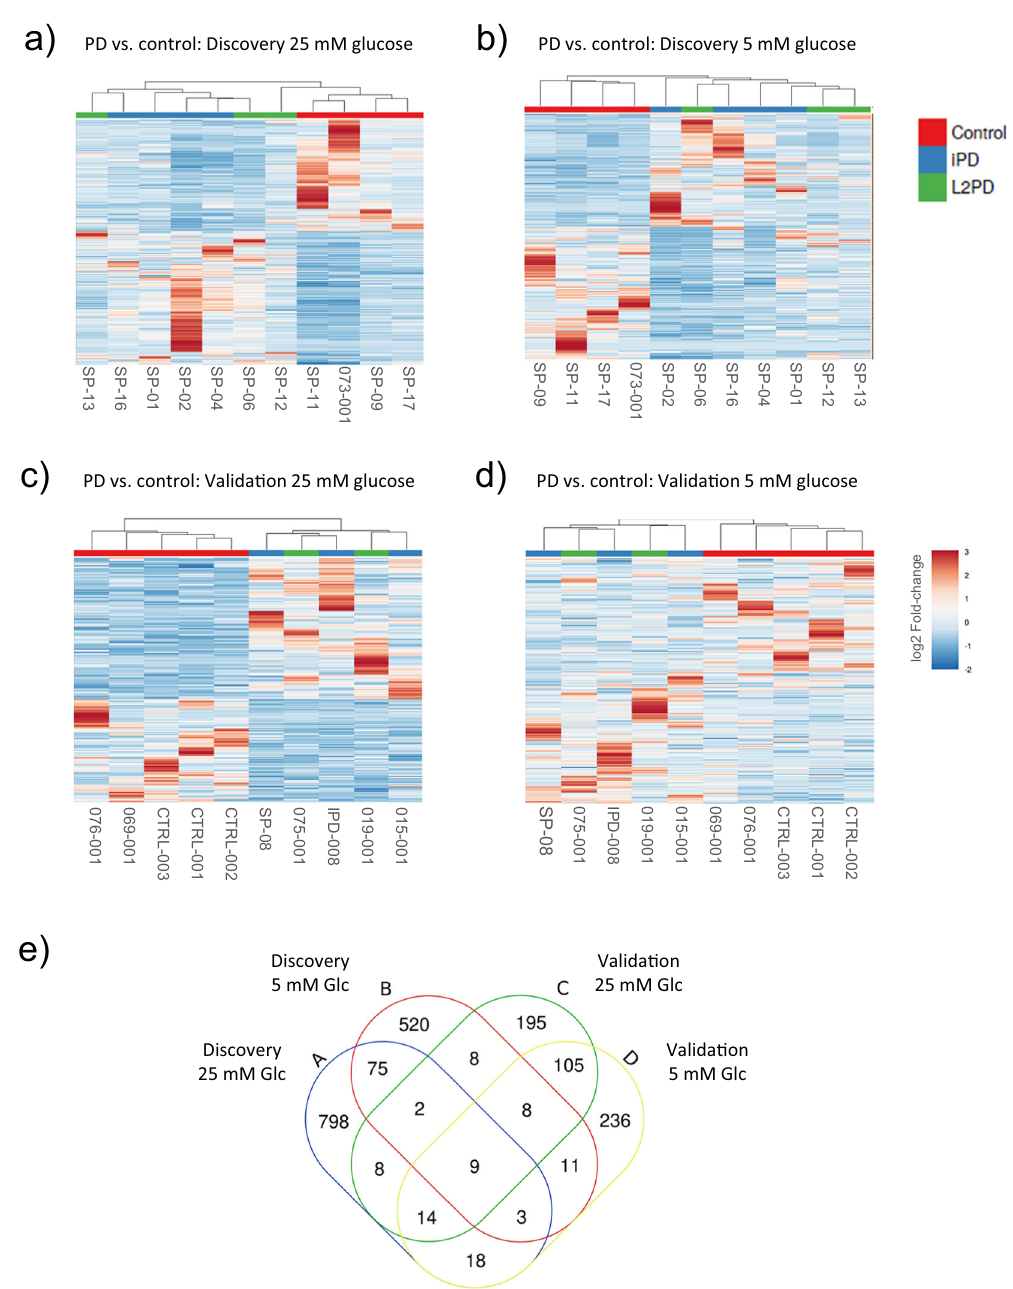
Fig. 2 Hierarchical clustering analysis of L2PD patients, iPD patients, and controls with heatmap density color representation of differentially expressed genes (DEGs) across different comparisons. a Discovery cohort at 25 mM glucose. b Discovery cohort at 5 mM glucose. c Validation cohort at 25 mM glucose. d Validation cohort at 5 mM glucose. Heatmaps of DEGs ( P -value<0.05 and fold change FC ≥ |2|) were performed using default settings at the Clustvis software. e Venn diagram representation showing DEG overlap between PD vs. controls in the four different comparisons, where “ A ” corresponds to discovery 25 mM glucose, “ B ” discovery 5 mM glucose, “ C ” Validation 25 mM glucose, and “ D ” validation 5 mM glucose. Clustvis: fi ndings that the main expression changes detected in iPD and neuron or synapsis in iPD and L2PD. These results can be L2PD fi broblasts are related to cytoskeleton rather than interpreted given that neurons and non-neuronal peripheral cells mitochondria, additional functional studies investigating the such as fi broblasts share common molecular mechanisms invol- interplay between gene expression deregulation and ving cell adhesion and extracellular matrix leading to fi lopodia and cytoskeleton-related processes are warranted in PD fi broblasts, most especially given the easy availability and robustness of this cell model. In addition, some of the top hits across all comparisons (Fig. 1) have been previously linked to PD. For example, the APOC4-APOC2 protein was signi fi cantly altered in